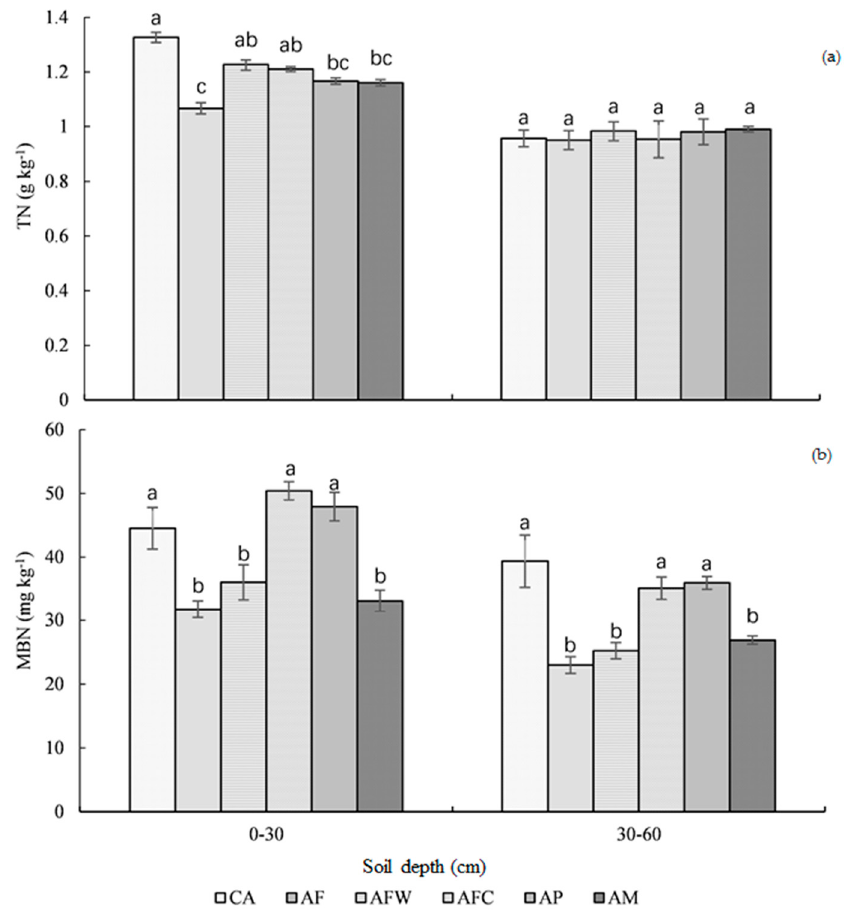
Figure 2. Soil nitrogen content at two soil depths in different cropping systems: ( a ) Soil total nitrogen (TN); ( b ) Soil microbial biomass nitrogen (MBN). Continuous alfalfa (CA), alfalfa-fallow (AF), alfalfa-fallow-wheat (AFW), alfalfa-fallow-maize (AFC), alfalfa-potato (AP), alfalfa-millet (AM). Error bars with different letters within a same soil depth indicate a significant difference at p < 0.05.